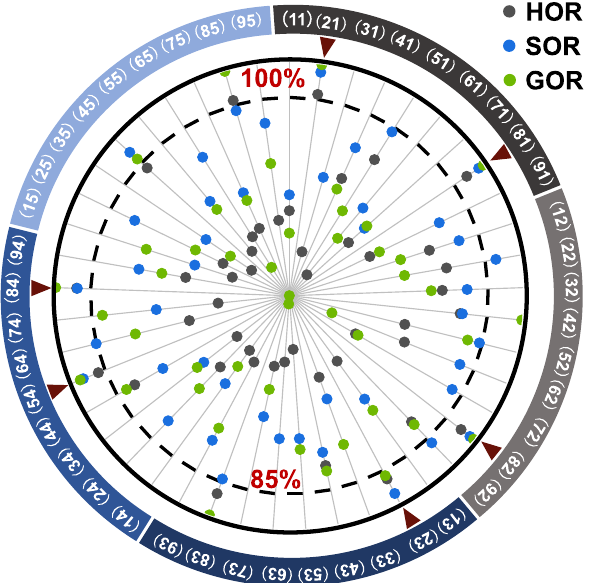
Fig. 3 Anti-HOR, anti-SOR and anti-GOR ability of polymers. Polymers scavenging over 85% of three radicals were selected for the next study (red arrows). Source data are provided as a Source Data fi le.